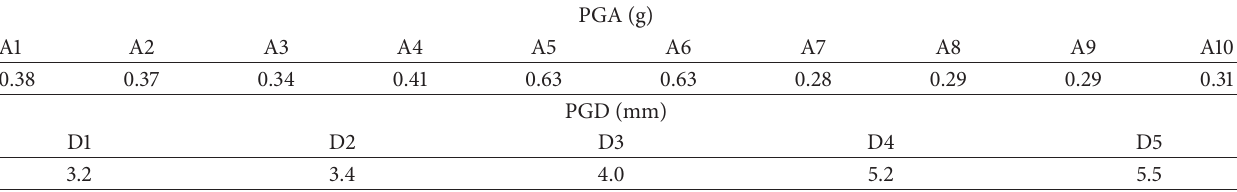
Table 2: PGA and PGD values of shake table test results.